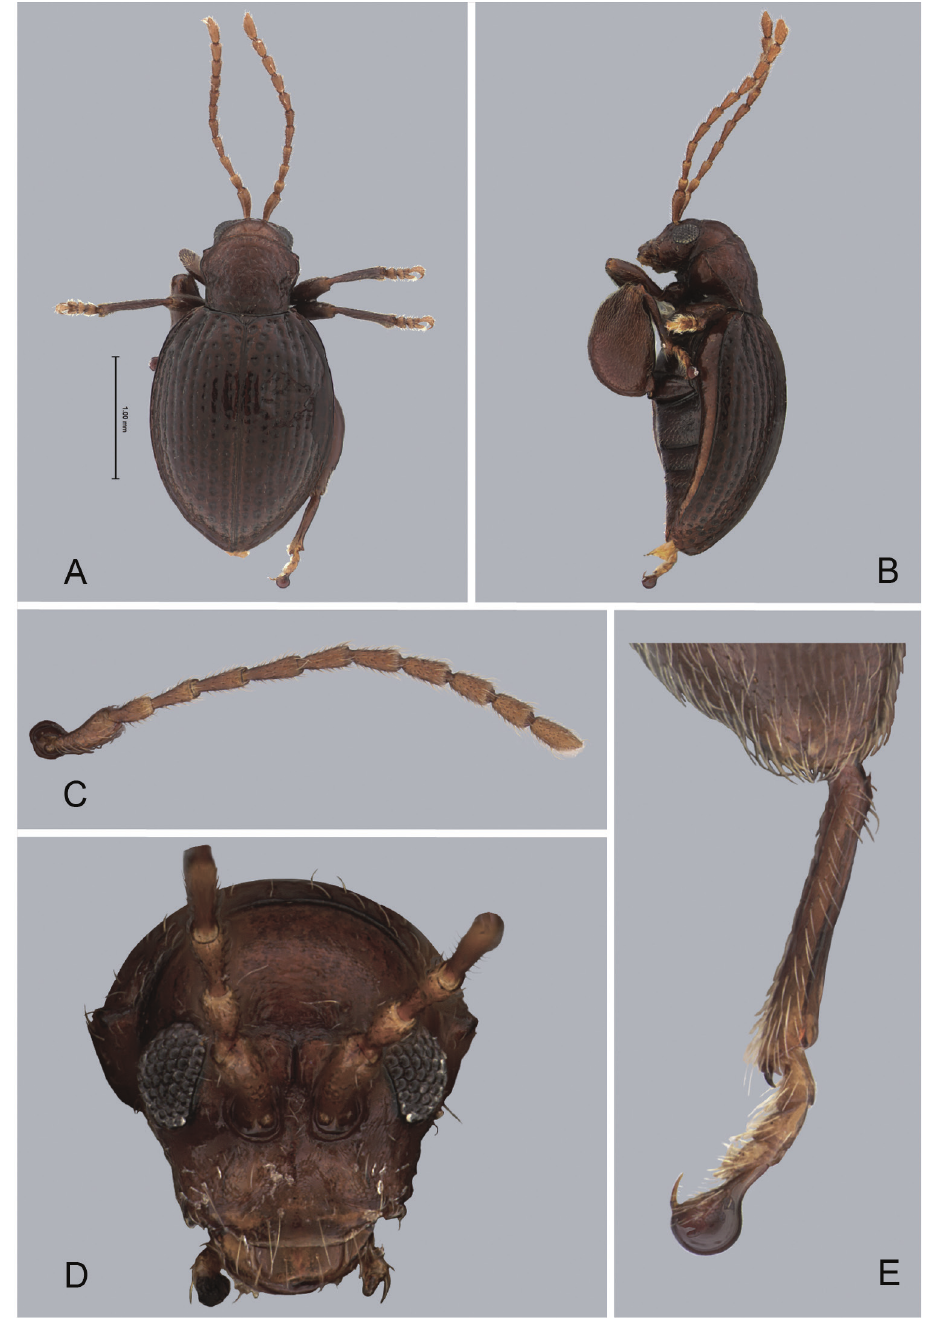
Figure 1. Andersonoplatus andersoni . A Habitus dorsal B Habitus lateral C Antenna D Head, frontal view E Hind